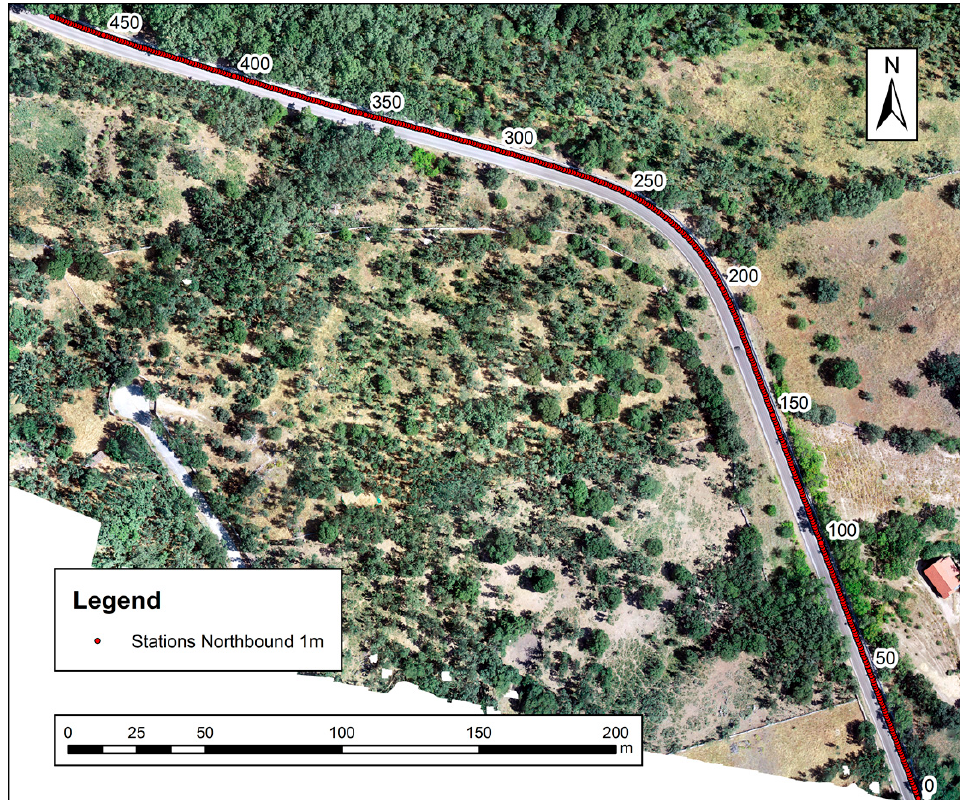
Figure 1. Map of the test site.